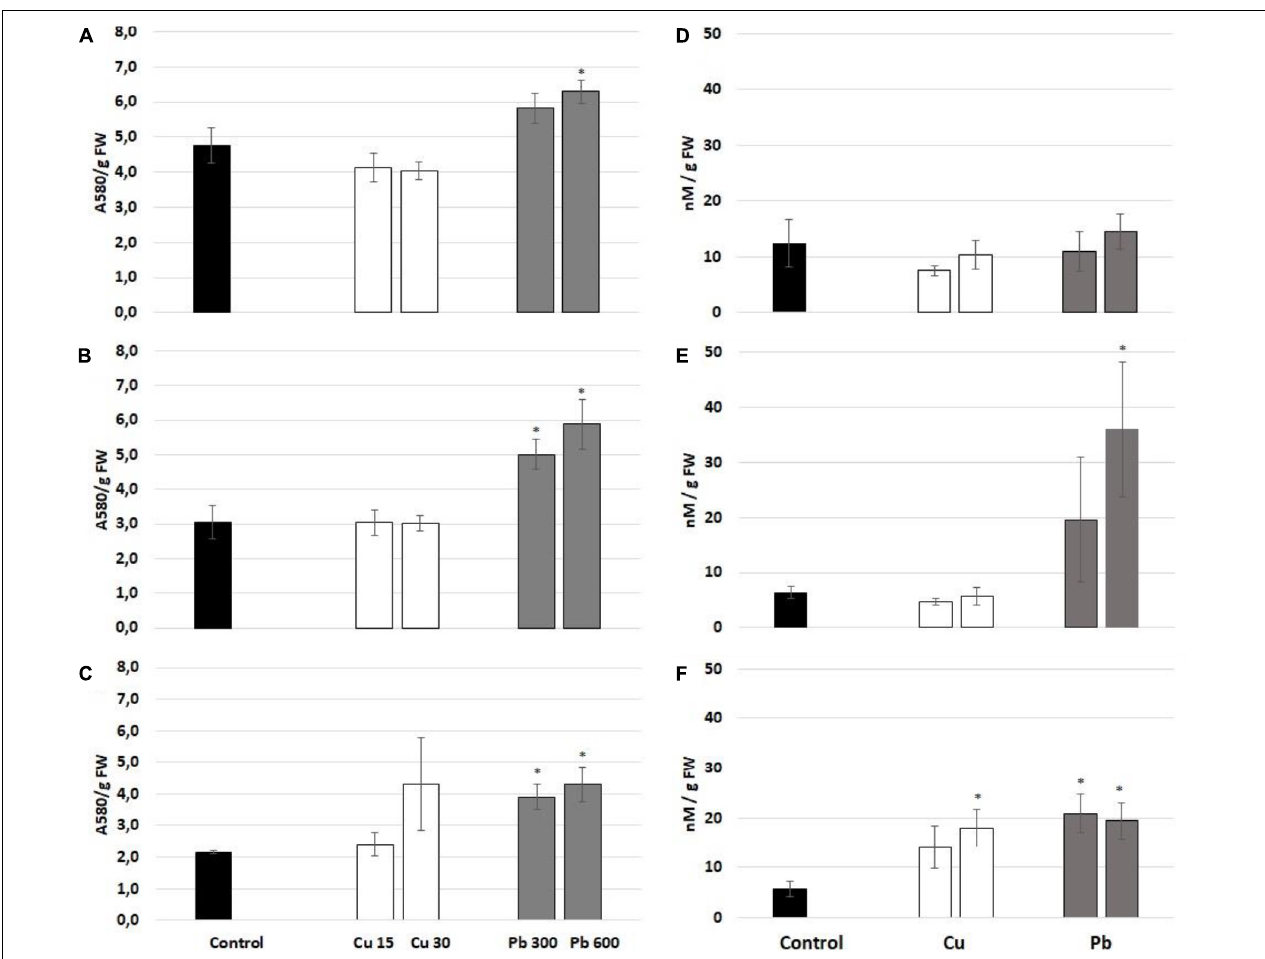
FIGURE 4 | The level of superoxide anion measured after 1 (A) , 3 (B) , and 24 h (C) and hydrogen peroxide assessed after 1 (D) , 3 (E) , and 24 h (F) in the roots of control (black bar) soybean seedlings and the roots of soybean seedling exposed to Cu at concentrations 15 and 30 mg/l (white bars) and Pb at the concentration 300 and 600 mg/l (gray bars). The results are means of 3–6 experimental repetitions ± standard error. The statistically significant differences in relation to the control are marked with asterisk